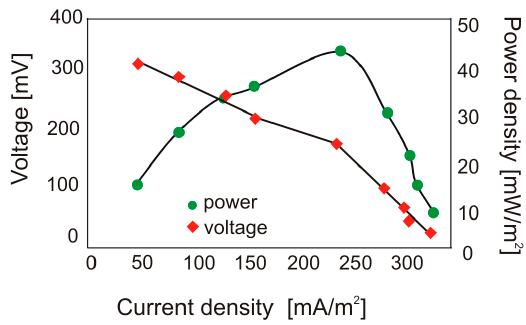
Figure 2. Polarization and power density curves of cellulose-fed MFCs.